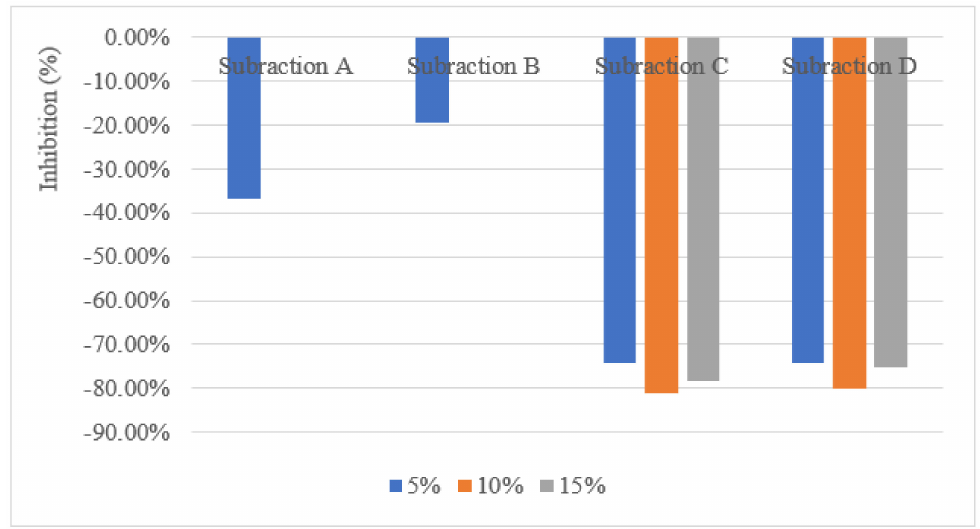
Figure 4. Effect of ethyl acetate A. conyzoides extract at different subfractions on root dry weight of A. spinosus at 21 DAA.